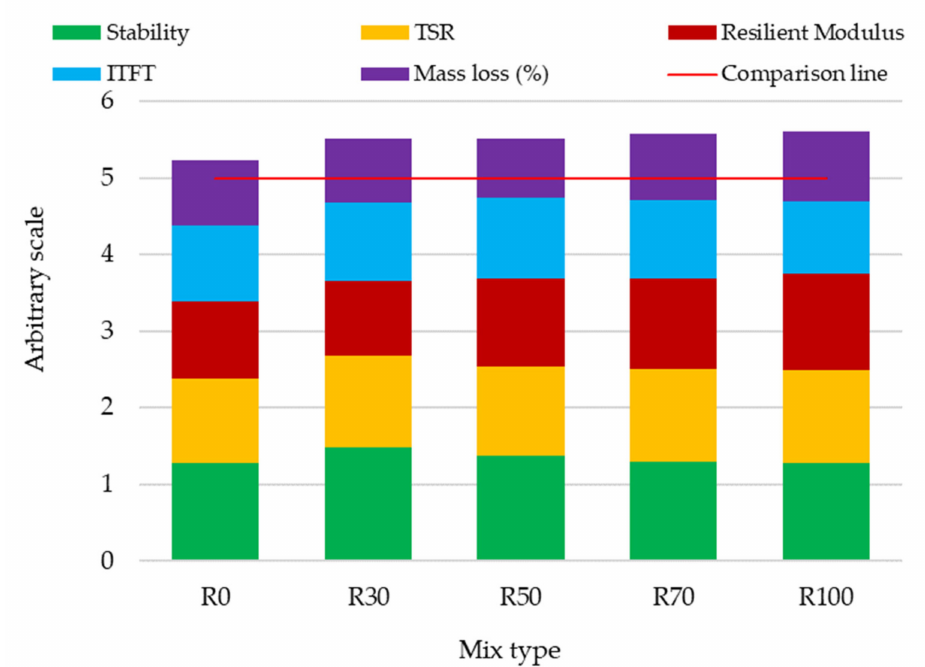
Figure 7. Comparison of the overall performance of the five mixes based on the arbitrary